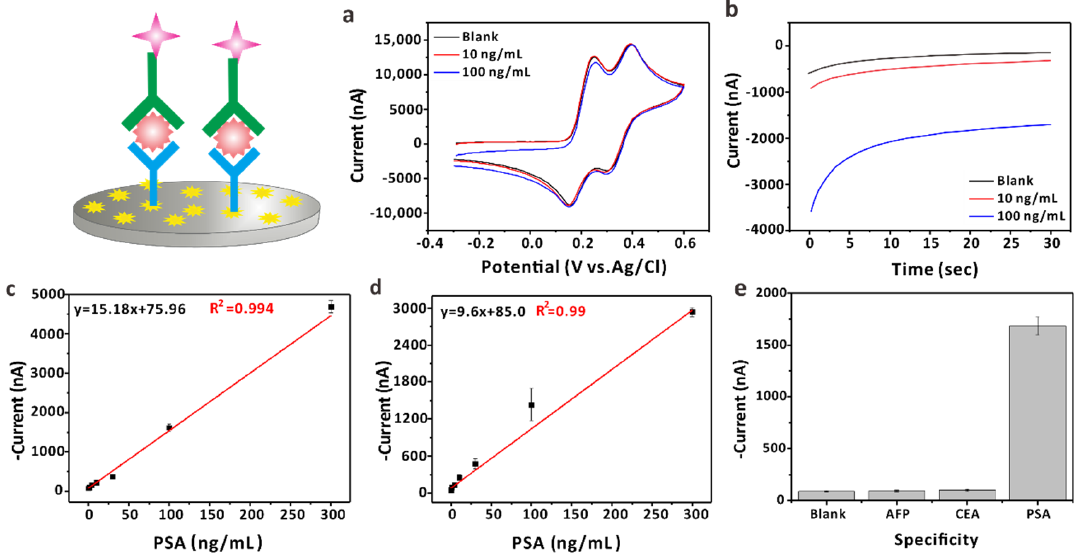
Figure 3. ( a ) CV curves in the detection of different concentrations of PSA. ( b ) i–t response in the presence of different concentrations of PSA. The potential was held at − 0.1 V and the reduction current was recorded at 30 s. ( c ) The linear fitting curve of the response current to PSA at a series of concentrations in PBS buffer. ( d ) The linear fitting curve of the response current to PSA at a series of concentrations in the normal human mixed serum. ( e ) Verification of the specificity of PSA biosensor chip, compared to the signal responses of the targets: AFP, CEA, and PSA at the same concentration level (100 ng/mL).